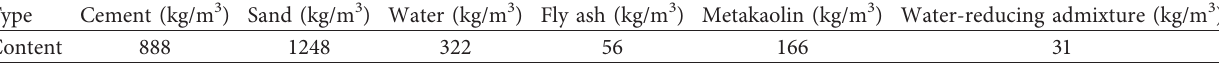
Table 1: Mortar mix proportion.